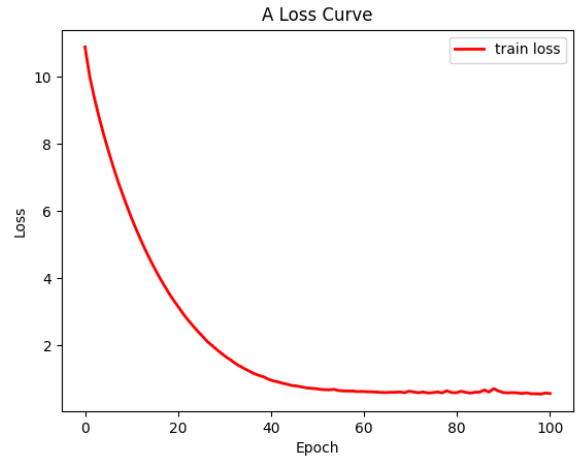
Figure 5. Loss value curve.